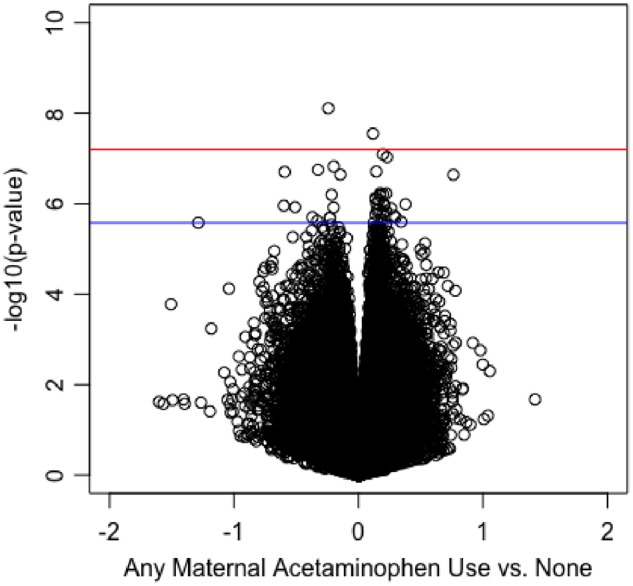
volcano plot illustrating the relationship between maternal acetaminophen use during pregnancy compared to no use with methylation across 790 677 CpGs, adjusted for maternal age, race/ethnicity, educational attainment, public health insurance status, cigarette smoke exposure, prepregnancy body mass index, maternal acute illness, maternal chronic illness, maternal NSAID use, parity, newborn sex, gestational age, birth weight, and putative cell type proportions. The blue line represents the false discovery rate (q < 0.05). The red line represents a Bonferroni correction of 6.3 × 10−8